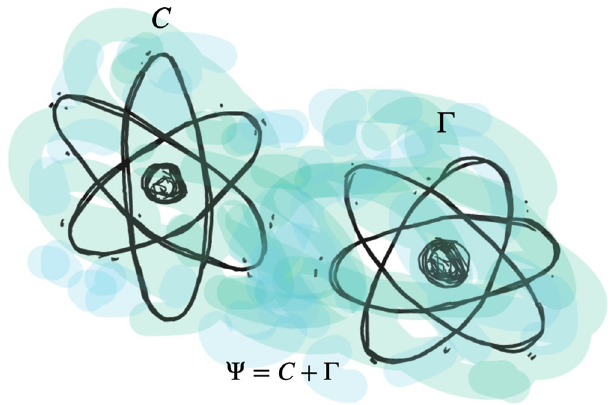
Fig. 1 A quantum clock for a quantum system. The clock C and the evolving system Γ make the isolated system Ψ , which is in the entangled state Ψ j ii .